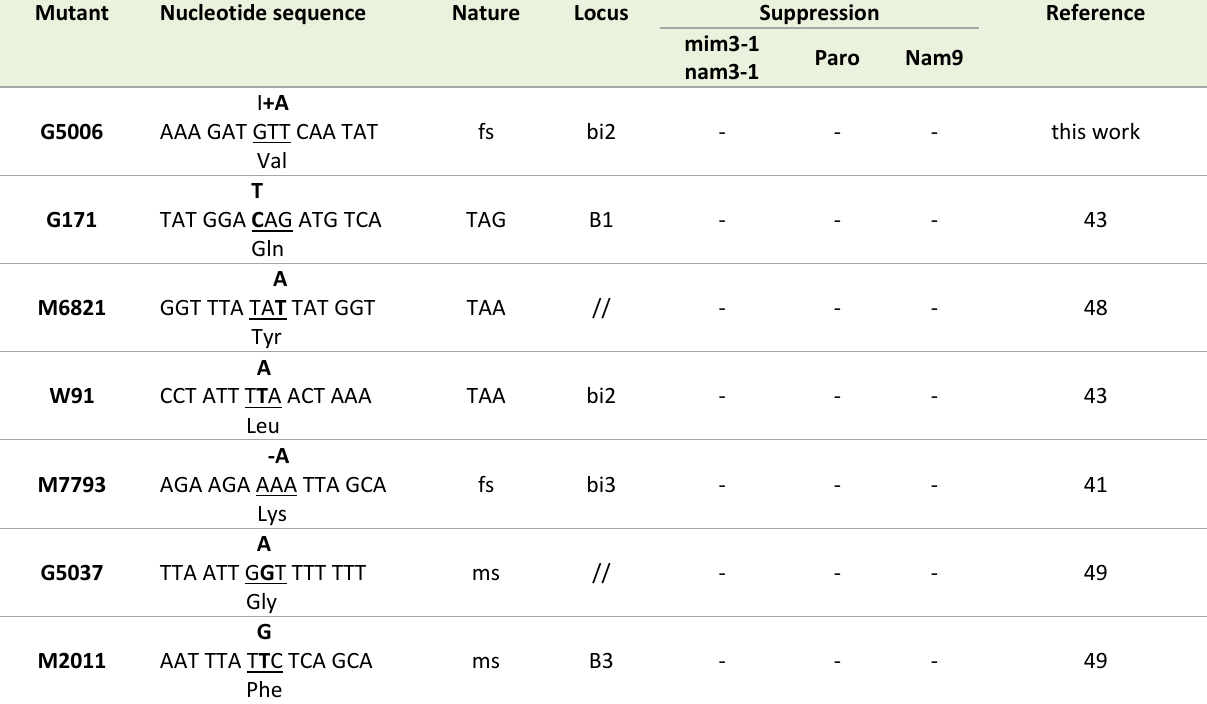
TABLE 2. Nucleotide sequence of mitochondrial mutations suppressed neither by mim3-1, NAM9-1 nor by nam3-1. Mutant Nucleotide